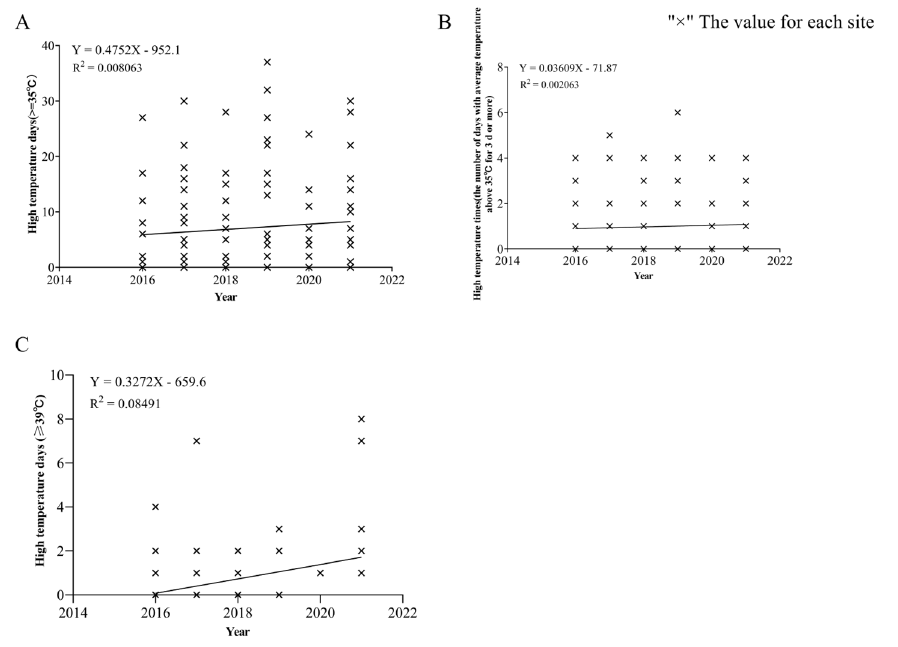
Figure 2. Analysis of high temperature at 19 stations in Northern Xinjiang. High temperature: Statistics of daily maximum temperature ≥ 35 °C at 19 stations in Northern Xinjiang from July to September 2016 to 2021. × is the value for each site. The line in the figure is a linear fit. ( A ) is the number of days when the temperature is higher than 35 °C at each station from 2016 to 2021; ( B ) is the number of times when the temperature is higher than 35 °C for 3 consecutive days or more at each station. ( C ) is the number of days when the temperature is higher than 39 °C at each station from 2016 to 2021.